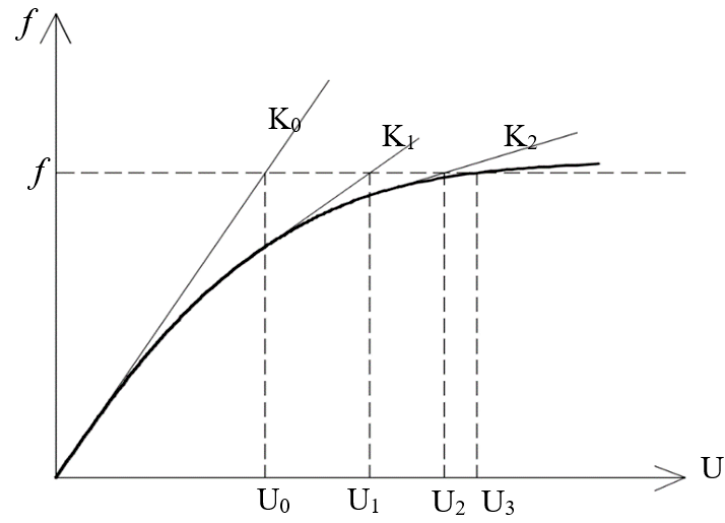
Figure 7. Nonlinear response of single degree of freedom system [35].